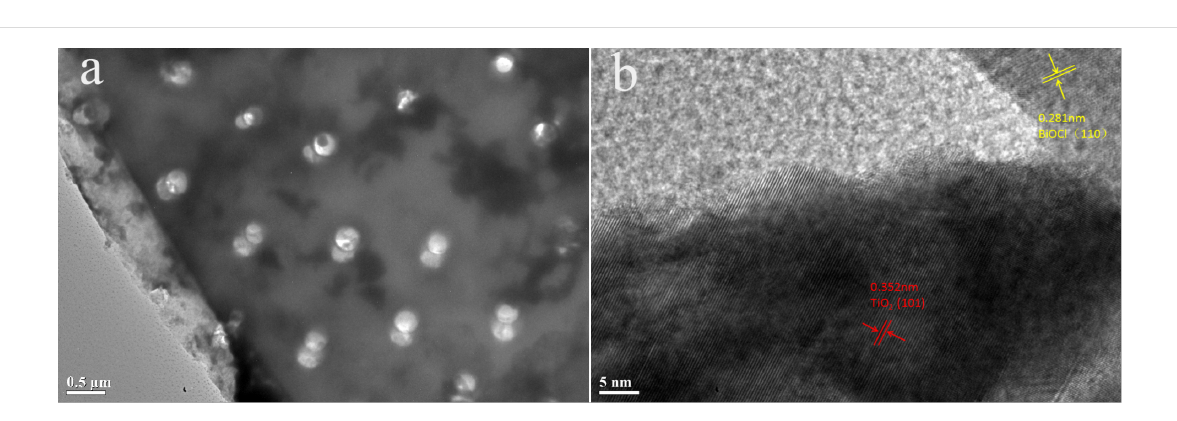
that the crystallinity of the composites is improved. The lattice fringes of 0.352 nm and 0.281 nm are matched with anatase TiO 2 (101) and BiOCl (110) planes, respectively. The